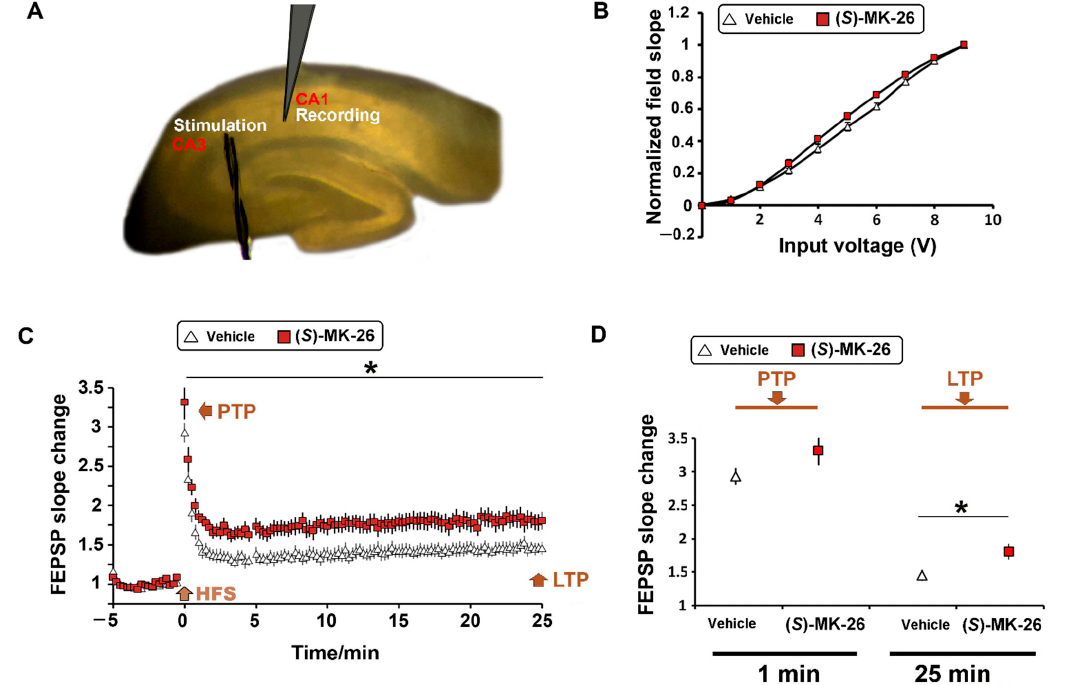
Figure 8. Effect of ( S )-MK-26 on synaptic functions in the rat hippocampus as examined electro- physiologically in slices. ( A ) Illustrative setting of a rat hippocampal slice with positioned